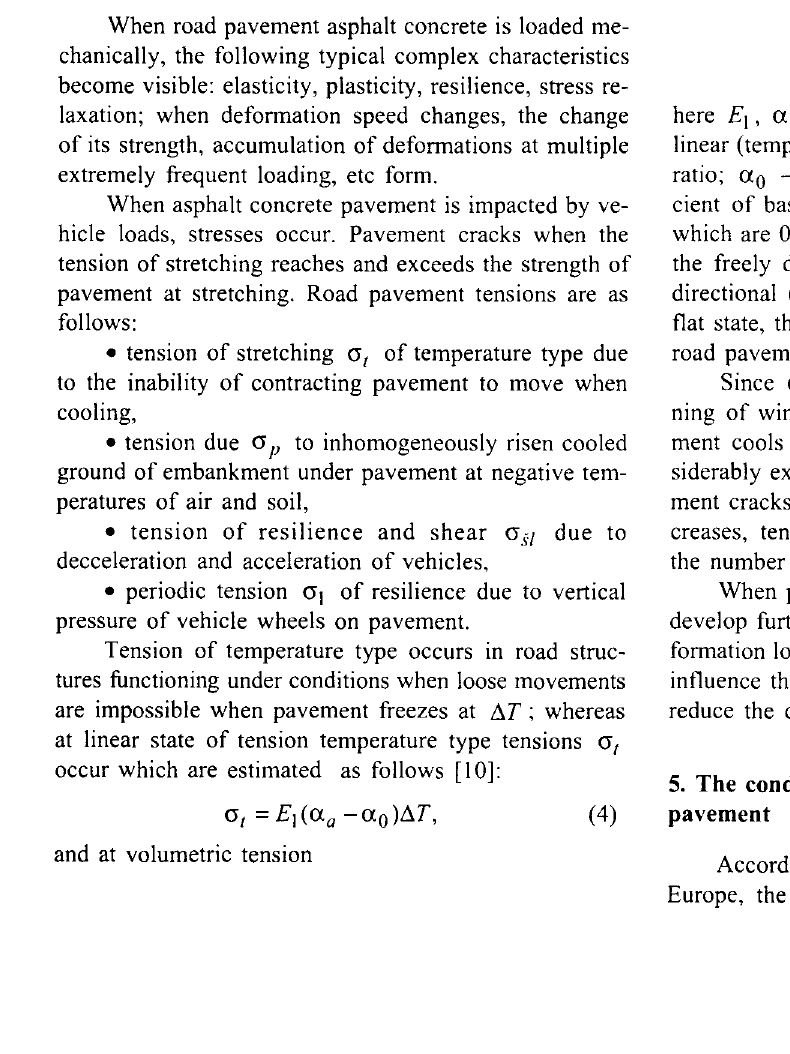
Fig 2. Dynamics of asphalt concrete pavement and its structural strength reduction when irremediable defects